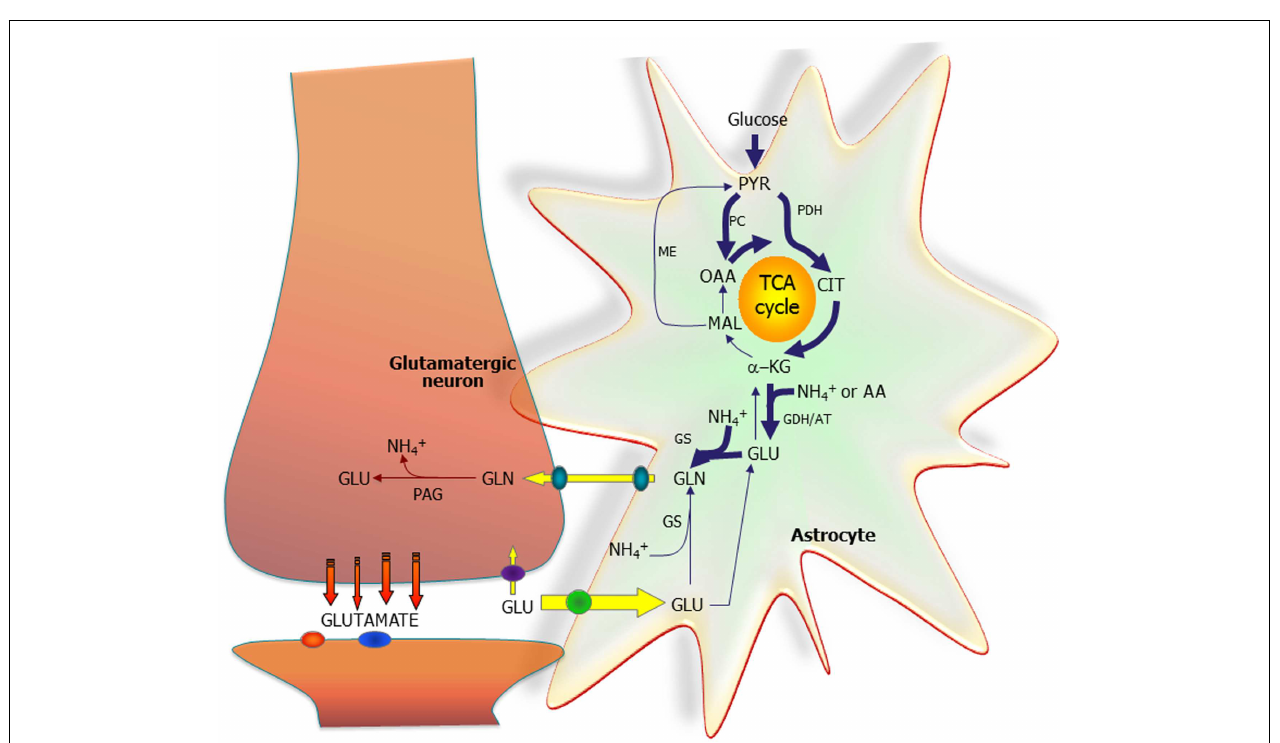
metabolized, which subsequently requires de novo synthesis of GLN via the anaplerotic processes indicated in bold arrows. Reproduced from Ref. (2), which together with other contributions discusses metabolic interactions in detail, even in the brain in vivo . However, the Figure also shows that NH 4 + is required in astrocytes and released in neurons, and mechanisms transferring NH 4 + /NH 3 between the two cell types are discussed in other articles. So are the transporters releasing glutamine from astrocytes and accumulating it in neurons and the powerful transporters accumulating glutamate in astrocytes, as well as associations between glutamate uptake and metabolism. AT, aminotransferase; MAL, malate; ME, malic enzyme; PYR, pyruvate. Figure from Schousboe et al.